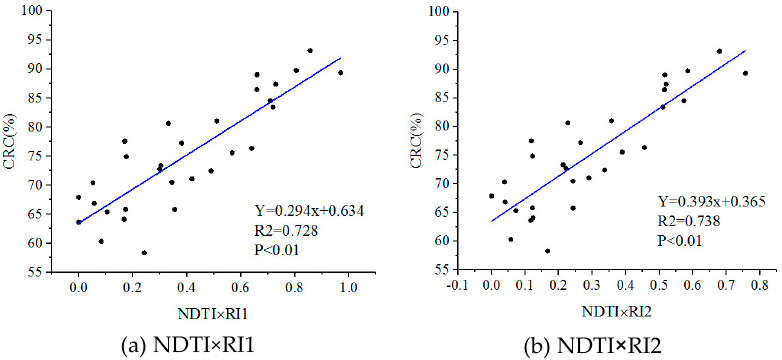
Figure 6. Regression between CRC and come combined OCRI-RPs.